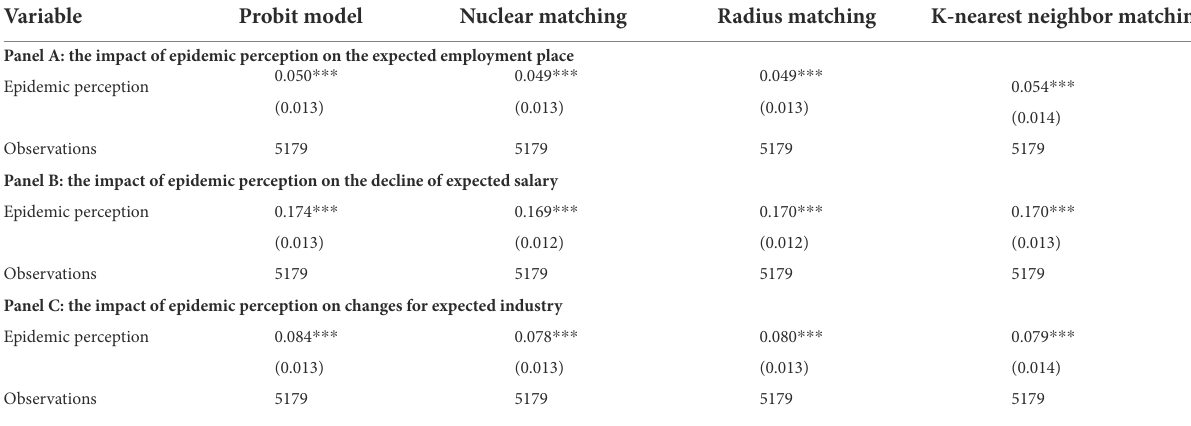
According to the online survey data of Zhaopin recruitment network platform. Marginal effects are reported in the table, and robust standard errors are shown in parentheses. In the regression, variables such as educational level, major type, family characteristics, and province are controlled. In the table above, the bandwidth of nuclear matching method is set to 0.01, the radius in radius matching is set to 0.005, and the number of K-nearest neighbor matching elements in caliper is 4. *** Significant at the level of 1%. ** Significant at the level of 5%. * Significant at the level of